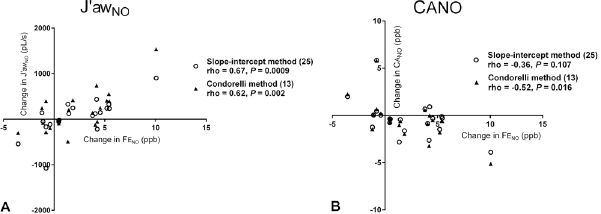
Fig 3. Scatter plots showing the correlation between the individual post-bronchodilator changes in FE NO 50, and J ’ aw NO , pL/s (A), and CA NO , ppb (B), relative to